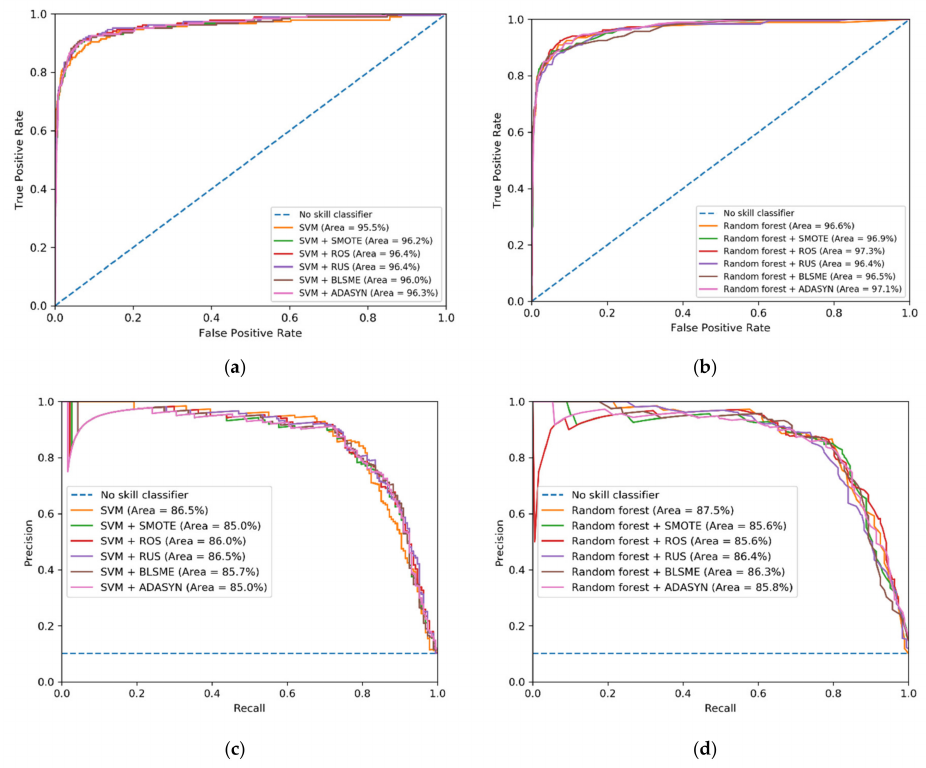
Figure A10. The ROC and PR curves of SVM and Random Forest for Fold 9; ( a ) the ROC curve of SVM; ( b ) the ROC curve of Random Forest; ( c ) the PR curve of SVM; and, ( d ) the PR curve of Random Forest.